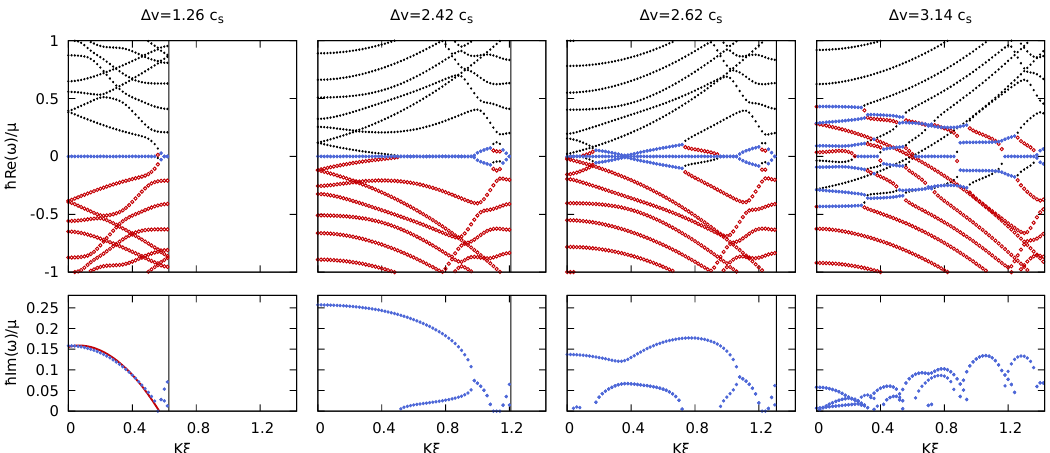
Figure 2: Real (top panels) and imaginary (bottom panels) parts of the eigenfre- quencies of the Bogoliubov problem as a function of the Bloch wavenumber K for = 20 ξ and four different values of the relative velocity ∆ v . For transverse size L y each ∆ v the K range is truncated at the edge of the Brillouin zone. Black filled dots correspond to positive-norm modes, red empty dots to negative-norm ones and blue thicker dots to zero-norm dynamically unstable modes, giving rise to the bubbles of instability visible in the lower plots. When ∆ v is high enough energetically unstable phononic modes begin to be present. Since L is finite and hence the phononic spec- y trum discrete, this velocity threshold is larger that 2 c and close to the 2.42 c value s s < ∆ v < 2.42 c used in the second panel. The spectra for values 1.26 c are similar s s to the one for ∆ v = 1.26 c . One can see the transition between the KHI regime, in s which the dominating instability is at K = 0, to a regime of SRI, in which the insta- bility maxima occur at finite K . For comparison, the red line in the leftmost lower panel is the hydrodynamic prediction (13), see Section 4.1 for